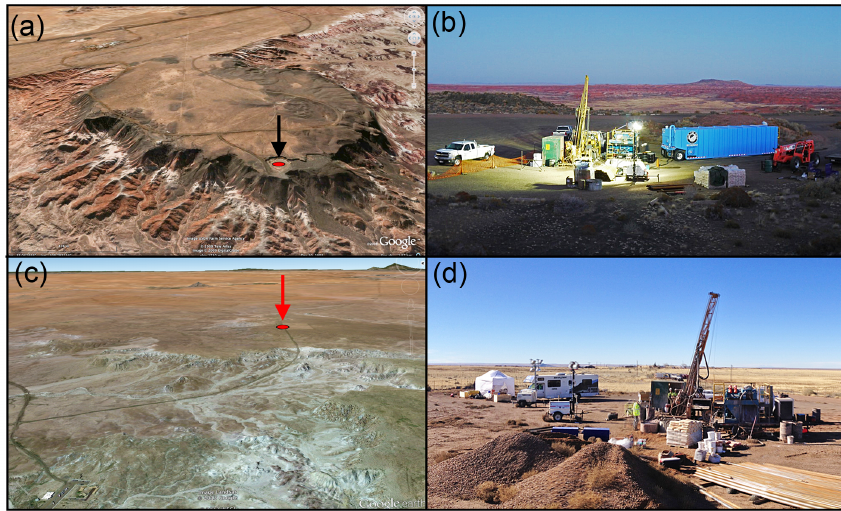
Figure 5. CPCP coring sites: (a) Chinde Point (GoogleEarth image) looking south with CPCP-PFNP13-1A coring site in the foreground (red dot and arrow) on mesa capped by Bidahochi Formation lava and lake strata overlying basal Owl Rock Member and Petrified Forest Member of the Chinle Formation with the prominent white band being the ash-rich Black Forest Bed of the upper Petrified Forest Member – Park Headquarters is at upper left; (b) CPCP-PFNP13-1A coring site at Chinde Point, looking north at dusk, during coring; (c) “West Bone Yard” (GoogleEarth image) site of CPCP-PFNP13-2A and -2B (red dot and arrow) looking west – hills in the distance are Hopi Buttes Bidahochi Formation mares and buildings in the foreground; left are parts of the Rainbow Forest Museum; (d) CPCP-PFNP13-2B site at “West Bone Yard” during coring, looking